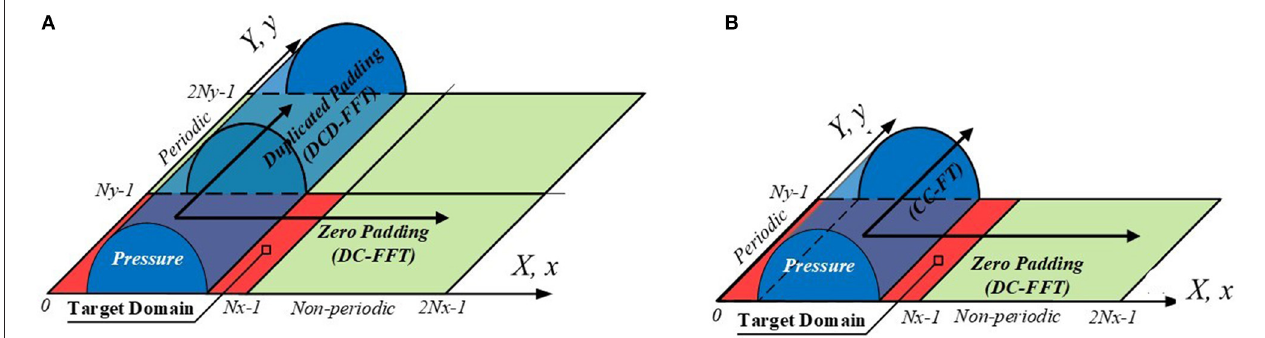
FIGURE 5 | DCD-FFT (A) and DC-CC-FFT (B) algorithms (based on Sun et al., 2020), Reprinted by permission from Springer, Computational Mechanics. The red areas mark the target domains, and the light green regions are for the IC wrap around.